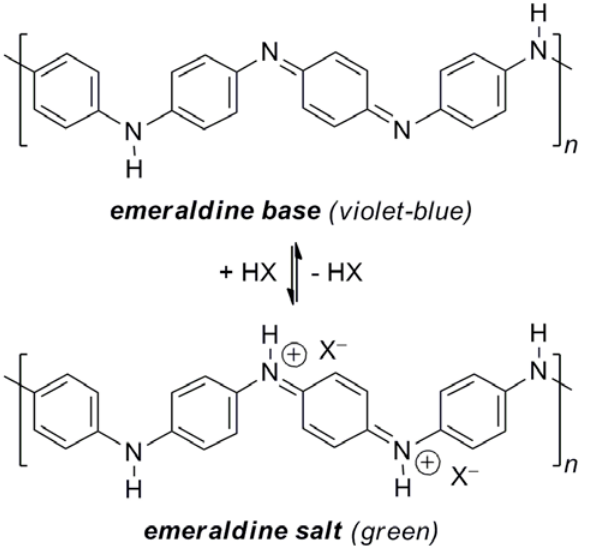
Figure 3. Protonic equilibria of polyaniline’s emeraldine form.